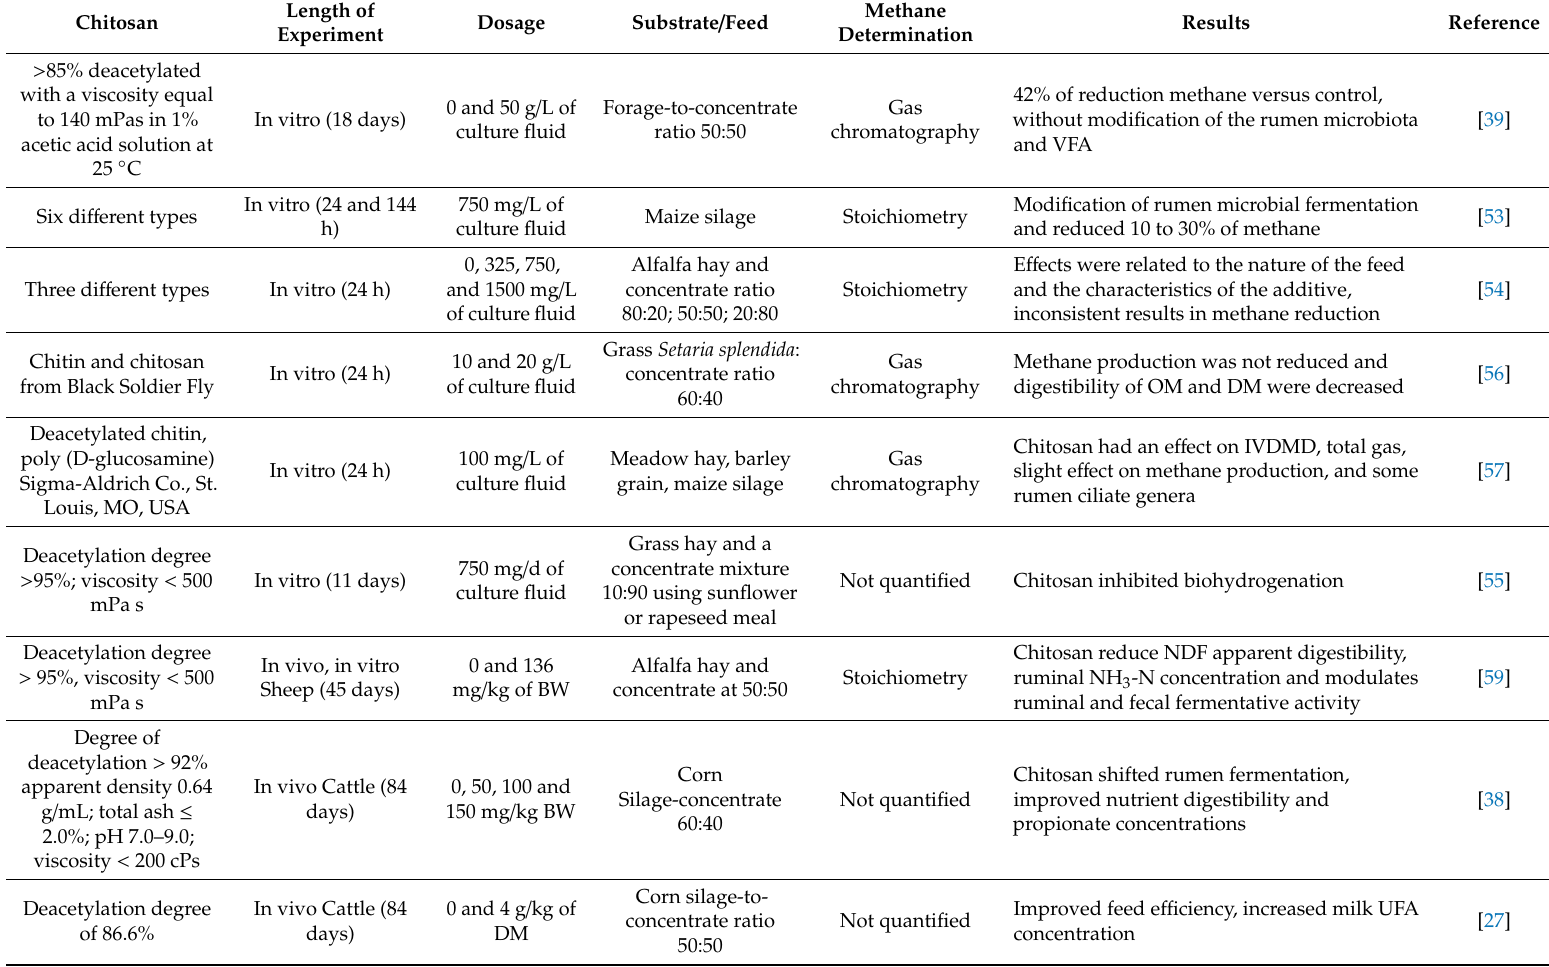
Table 1. E ff ects of chitosan on rumen fermentation and methane emission